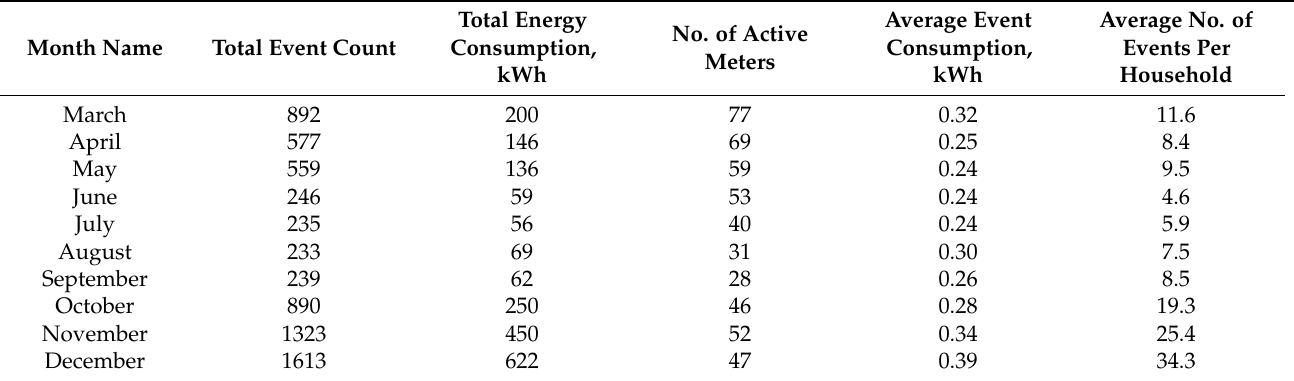
Table 5. Monthly smart meter